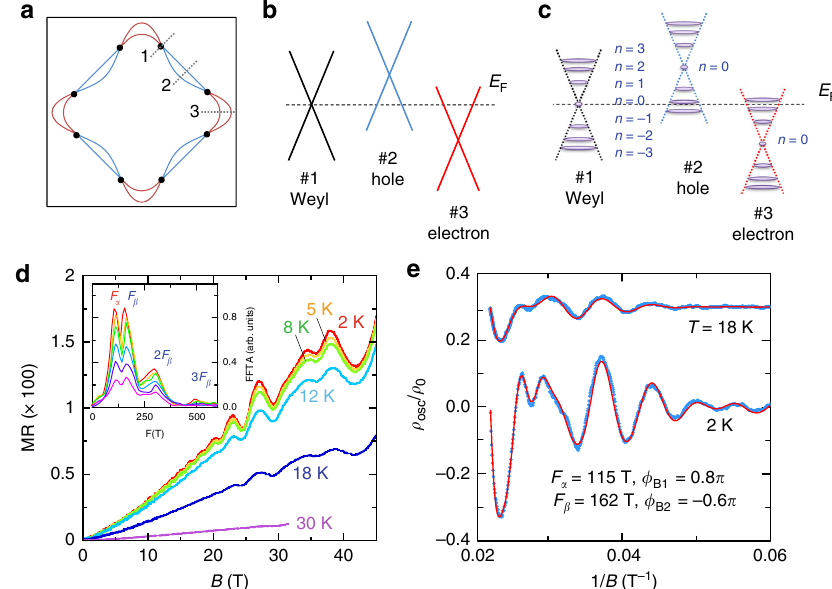
Fig. 1 Schematic electronic band structure and in-plane magnetotransport properties of YbMnBi 2 . a Schematic of YbMnBi 2 ’ s Fermi surface determined by ARPES experiments 24 . The red and blue pockets correspond to electron- and hole-like pockets, respectively. The black dots represent Weyl points. b Schematic of the linear band crossing for the electron- and hole-like pockets and the Weyl point, also determined by ARPES experiments for the cuts 1 – 3 shown in a 24 . c Schematic of Landau levels for three types of band crossings shown in b under high magnetic fi elds. We adopted the 2D Landau quantization mode because of the quasi-2D electronic structure of YbMnBi 2 . d , The normalized in-plane magnetoresistivity MR [ = ρ xx ð B Þ(cid:2) ρ xx ð B ¼ 0 Þ ρ function of magnetic fi eld along the out-of-plane direction. Inset , the FFT spectra of the SdH oscillations. e The fi ts of SdH oscillations at 2 and 18 K by the two-band LK formula (see the Methods section for more details for the fi ts). The SdH oscillatory component ρ osc is obtained by subtracting